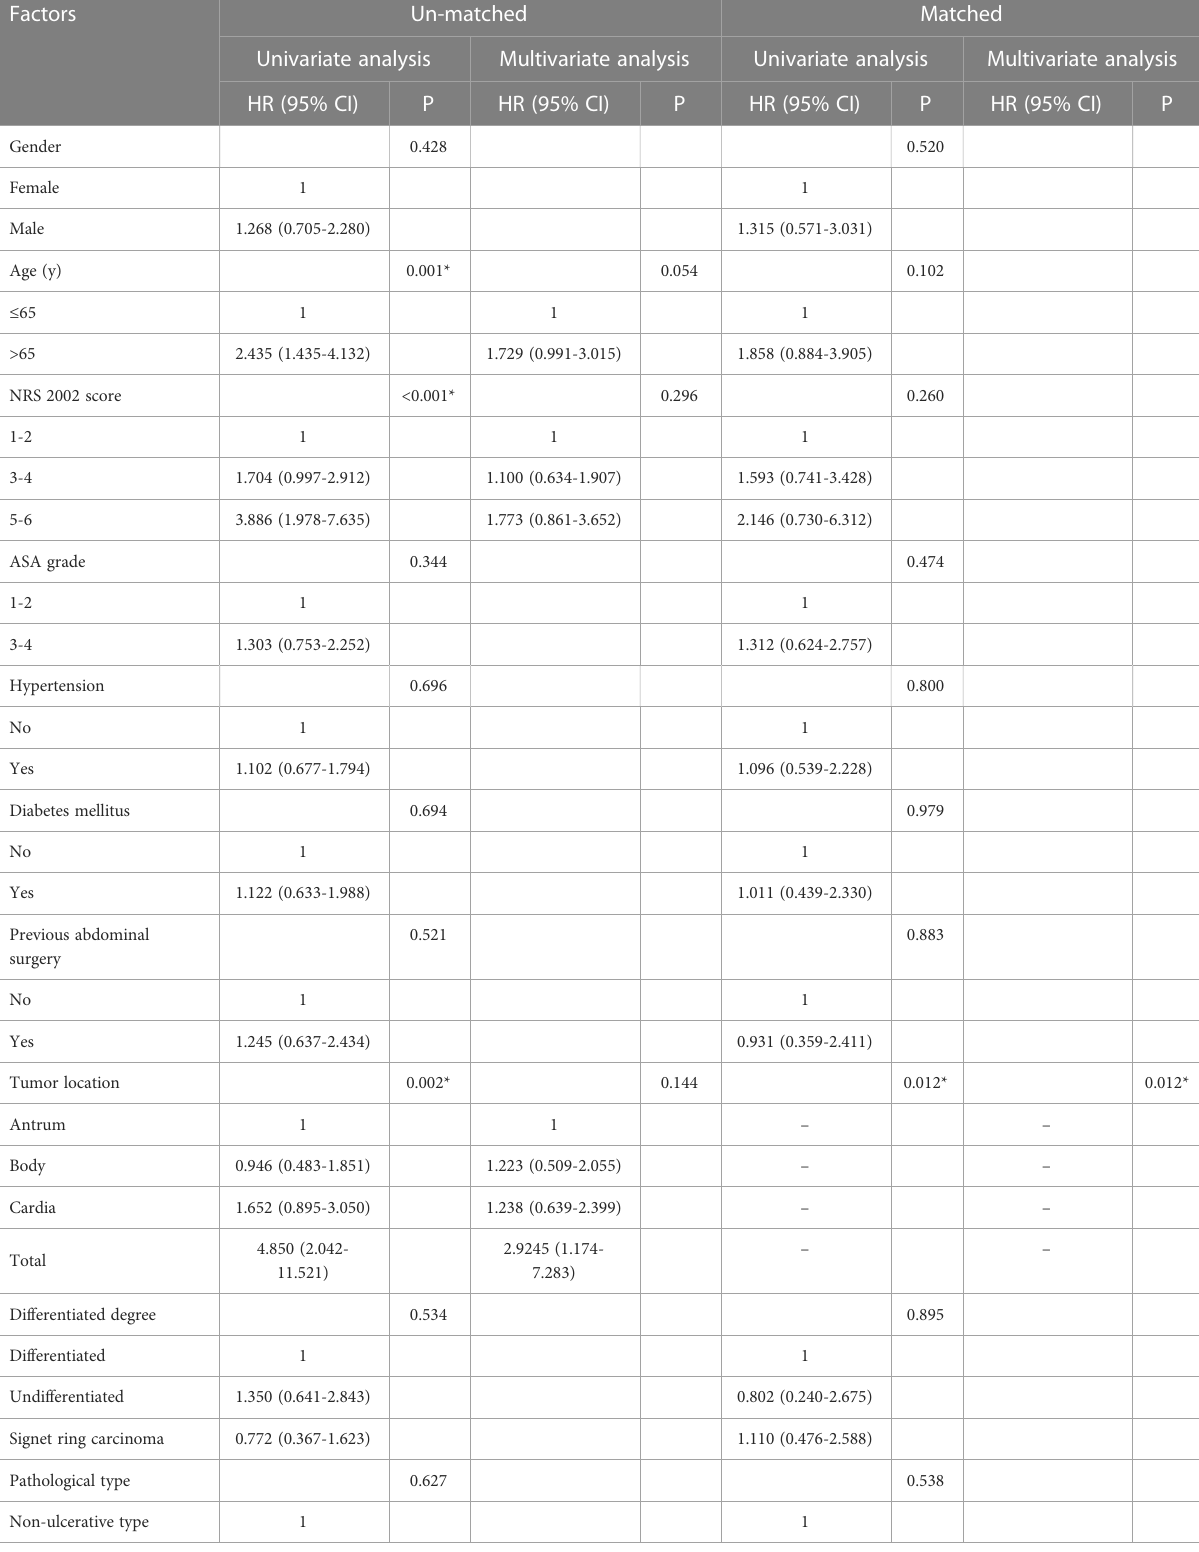
TABLE 5 Univariate and multivariate COX regression analysis of factors associated with overall